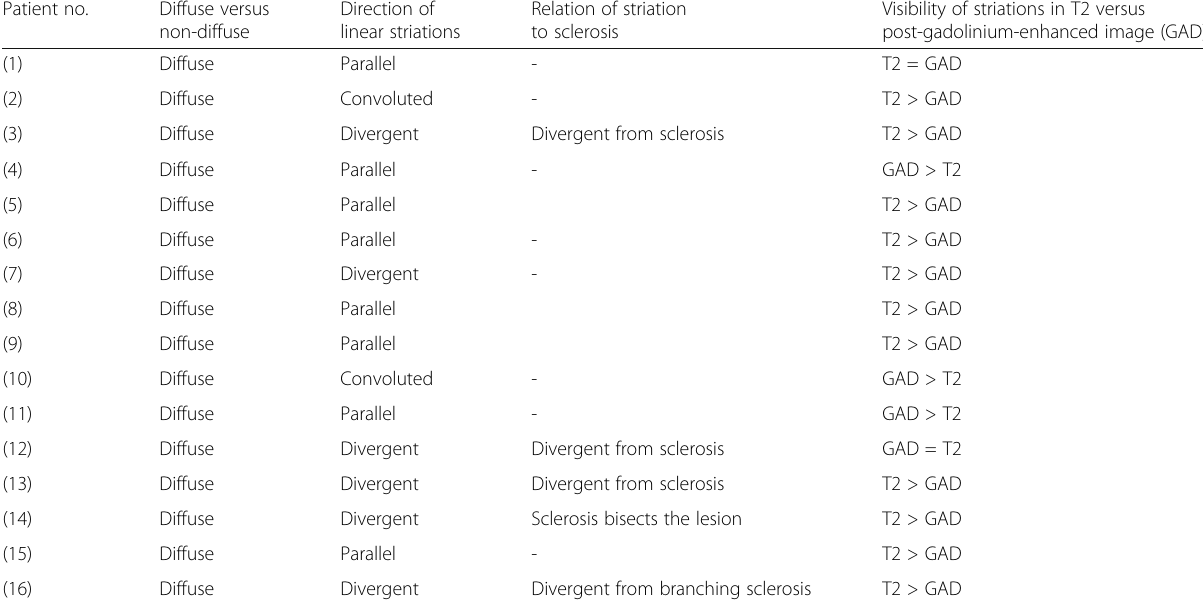
Table 4 Magnetic resonance imaging features of the “ striated pattern ” sign, using different parameters Patient